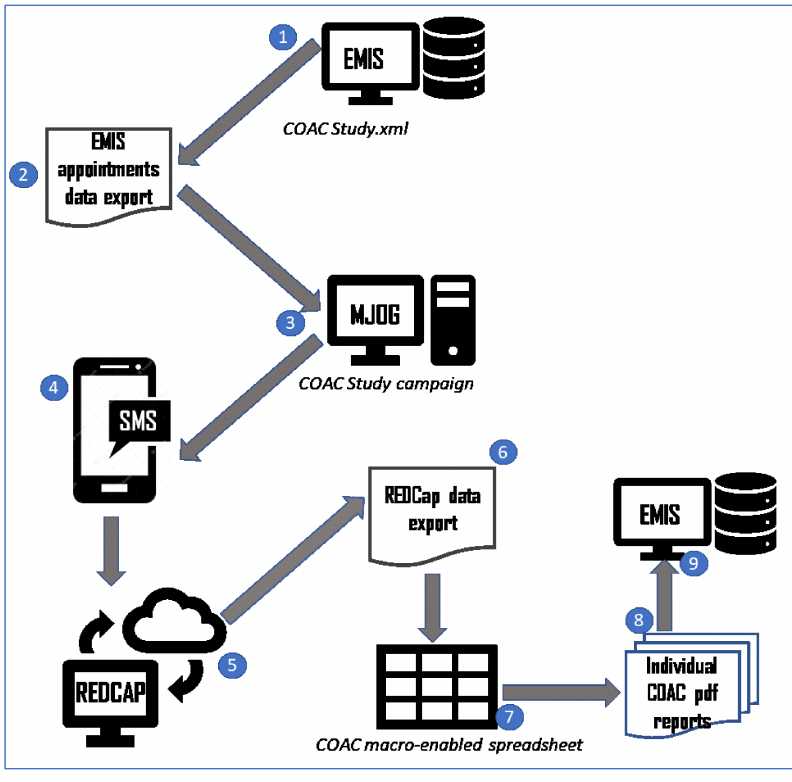
Figure 13. pre-consultation report generation: process diagram.